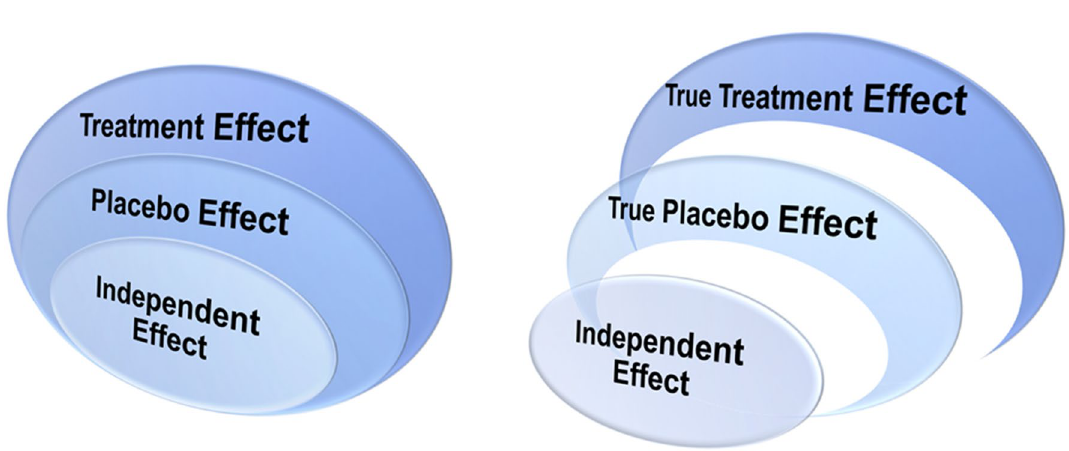
Figure 5. The additive model of placebo effect. The observed treatment effect includes the observed placebo effect, while the observed placebo effect includes independent effect (e.g., spontaneous improvement and natural course of the disease). In an additive model, the true treatment effect is the observed treatment effect subtracting the true placebo effect and the independent effect, and the true placebo effect is the observed placebo effect subtracting the independent